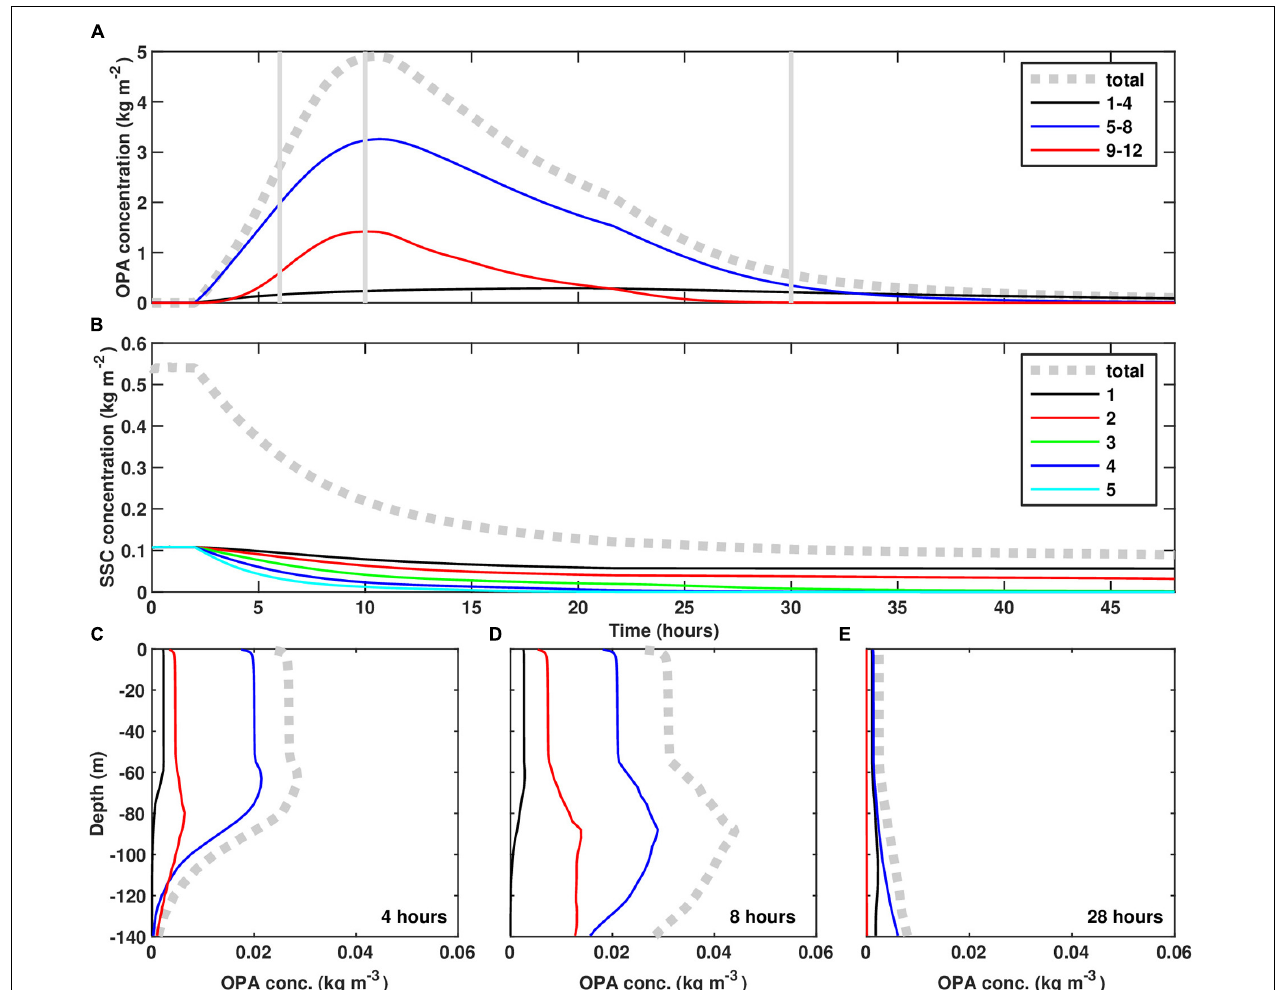
FIGURE 9 | Time-series for the river plume scenario of depth-integrated (A) OPA mass concentration and (B) SSC mass concentration. Profiles of OPA concentration at (C) hour 4, (D) hour 8, and (E) hour 28 after activating OPAMOD, respectively. Lines in panels (C–E) share the same legend shown in panel (A) , with dotted gray line representing the total OPA size classes, black line representing the OPA size classes from 1 to 4, blue line representing the OPA size classes from 5 to 8, and red line representing the OPA size classes from 9 to 12,